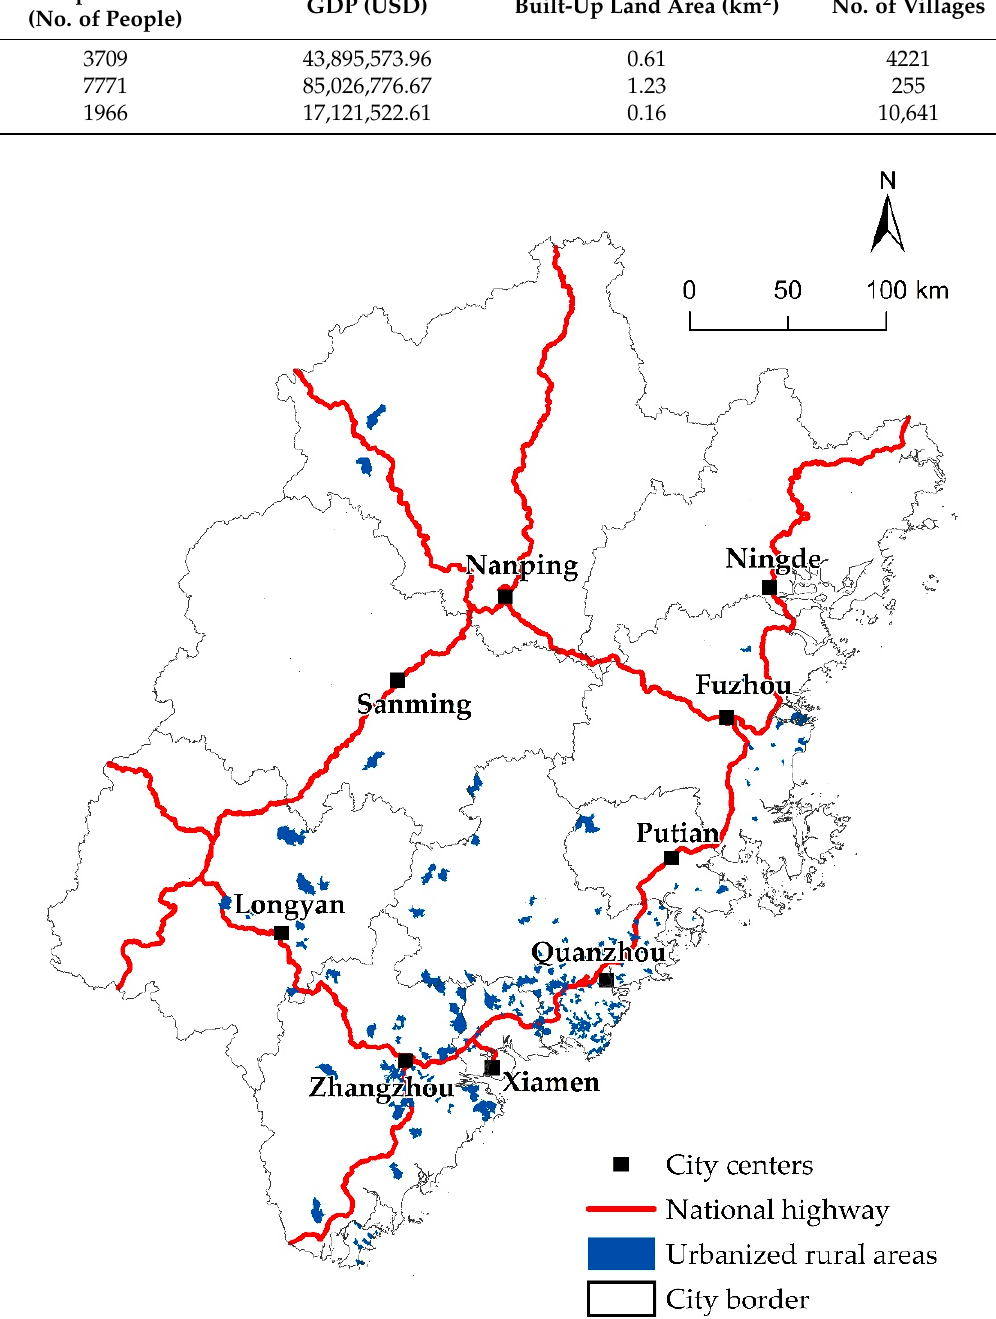
Figure 3. The spatial distribution of 255 urbanized rural areas in nine prefecture-level cities in Fujian Province in 2015.